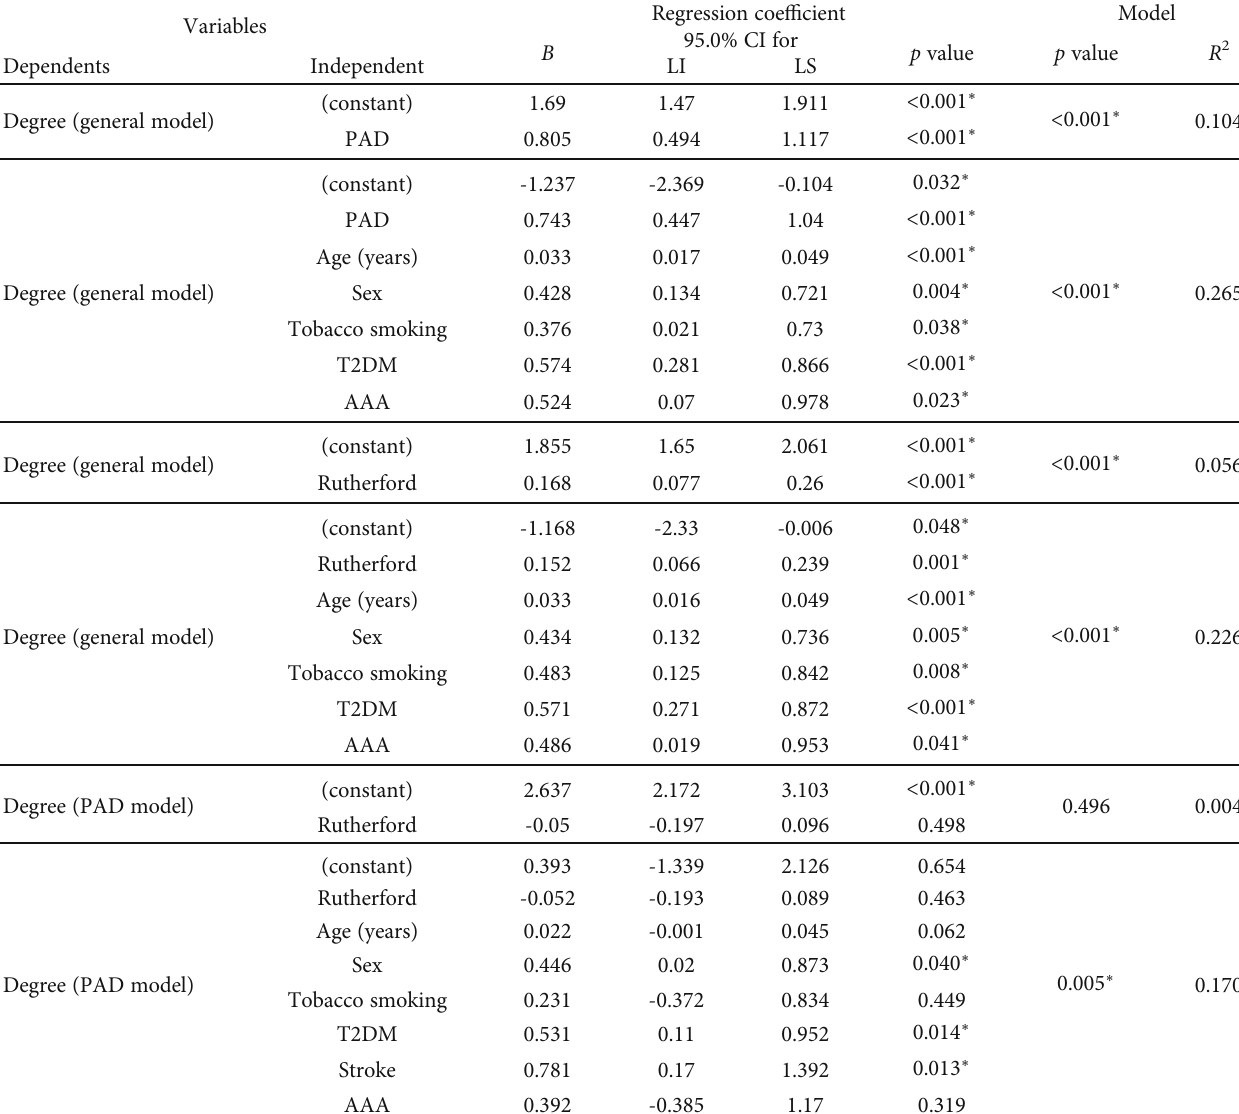
Table 4: Linear regression analysis for the e ff ect of independent variables on the degree of obstruction for the total sample (general model) and for patients with PAD (PAD